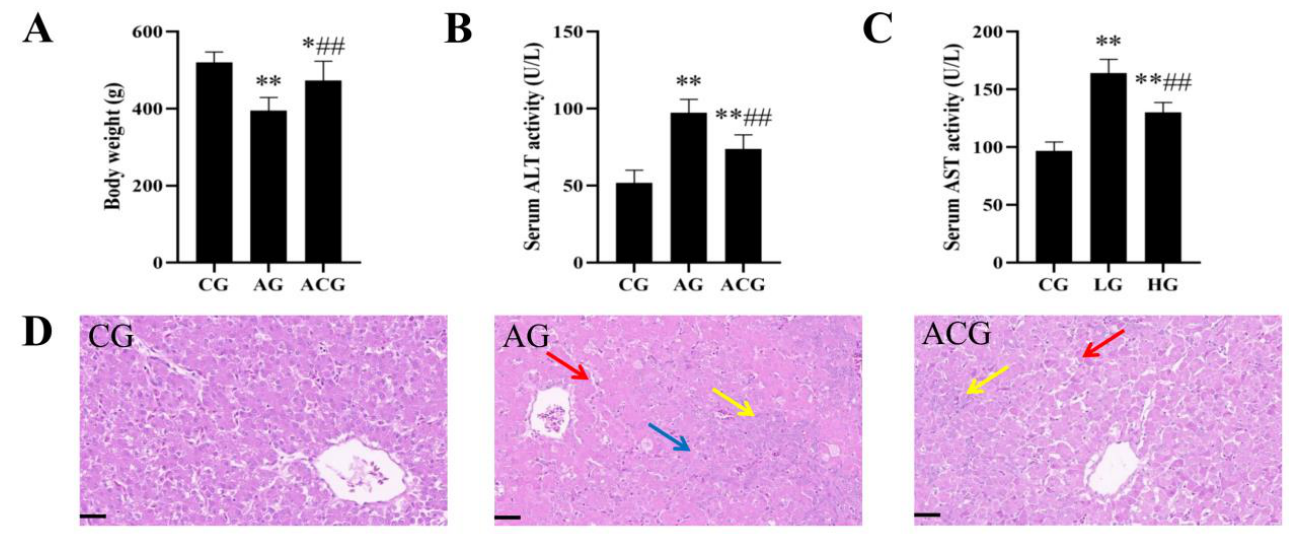
Figure 5. Curcumin alleviated liver damage caused by AFB 1 in ducks. ( A ) Body weight ( n = 6). ( B ) Serum ALT activity ( n = 6). ( C ) Serum AST activity ( n = 6). ( D ) Representative images of liver HE staining (red arrow: disordered hepatic cords; yellow arrow: infiltrated inflammatory cells; blue arrow: hepatocyte disintegration). Scale bar: 50 μm. * p < 0.05 and ** p < 0.01 vs. the CG. ## p < 0.01 vs. the AG.